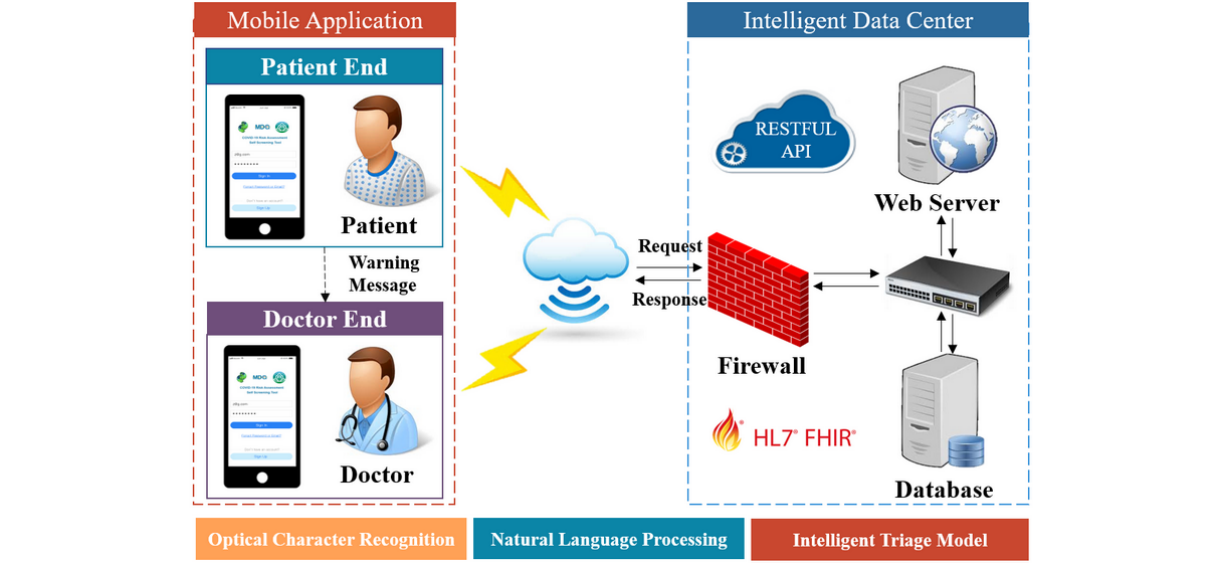
Figure 4. System architecture diagram. API: application programming interface; FHIR: Fast Healthcare Interoperability Resources; HL7: Health Level 7; RESTFUL: representational state